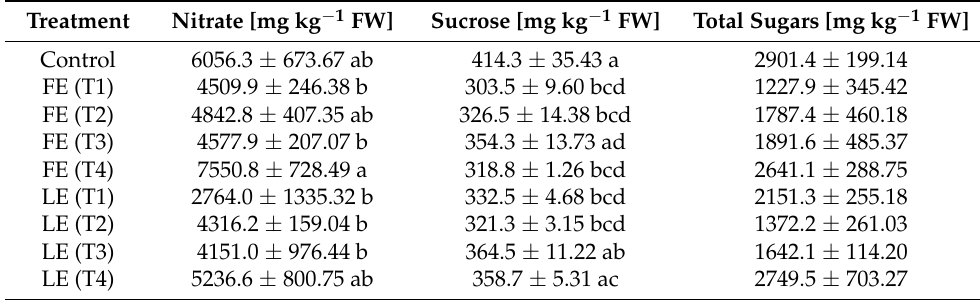
Table 3. Nitrate and sugar concentrations of rocket leaves treated with water (control = C) and with borage extracts (flowers extract = FE or leaves extract = LE) obtained with different maceration times: 1 day (T1), 3 days (T2), 7 days (T3), and 14 days (T4). Values are means ± SE ( n = 3). Data were subjected to one-way ANOVA. Different letters, where present, represent significant differences among